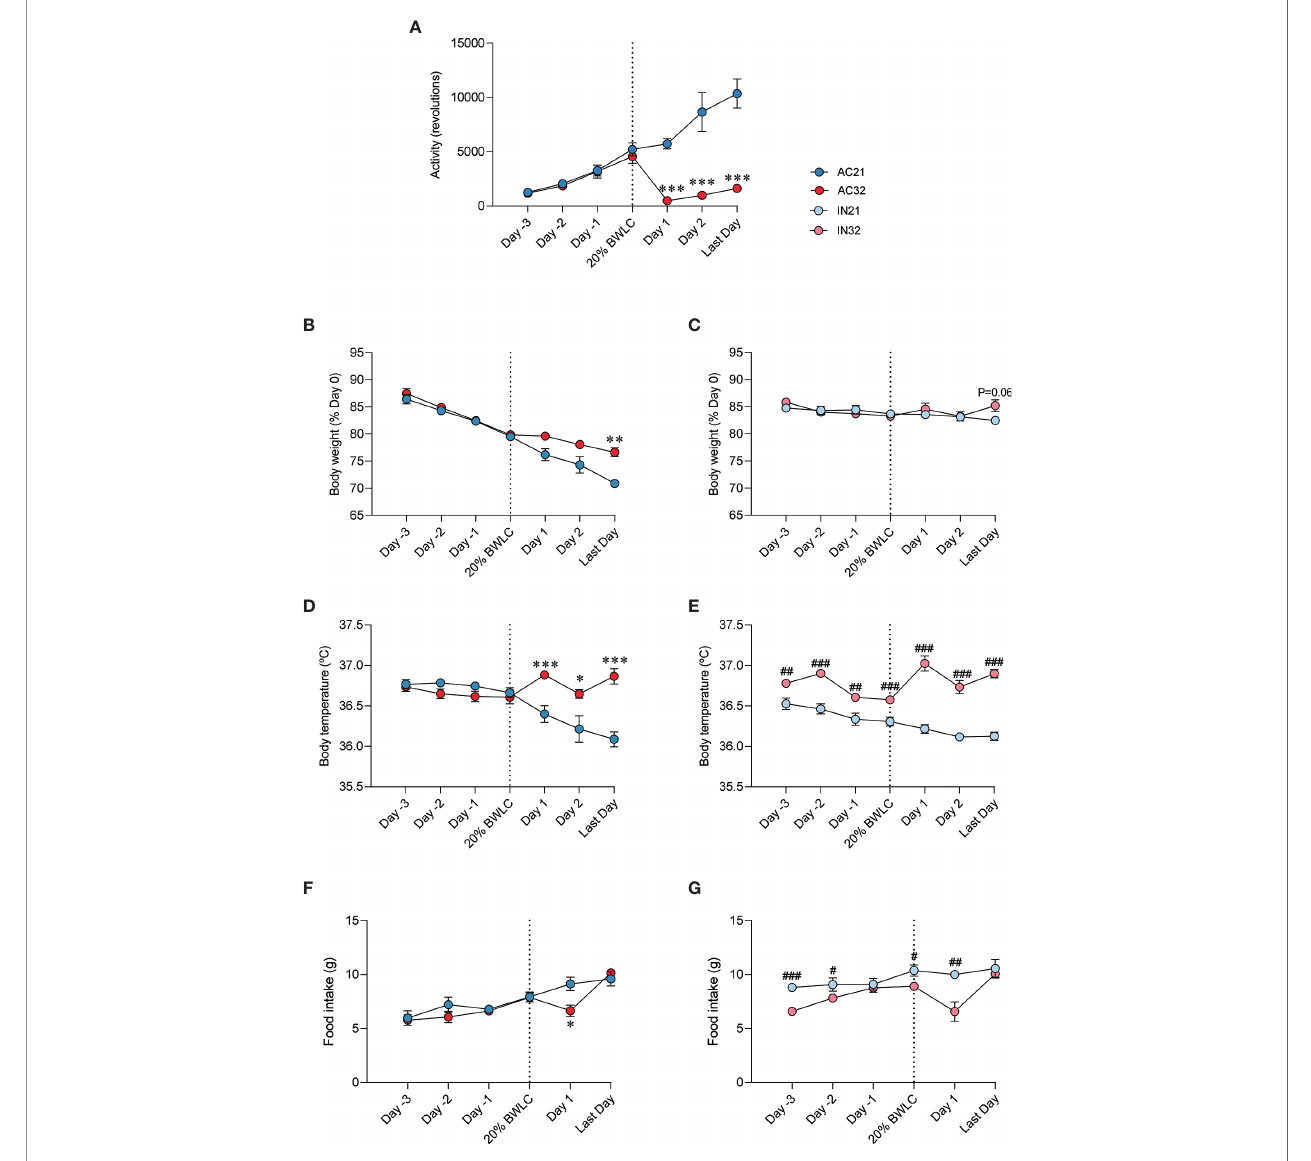
FIGURE 1 | Effect of ABA and temperature on energy balance. (A) Activity (n = 9-12 rats/group) (B, C) Body weight (% of day 0) (n = 8-12 rats/group) (D, E) Body temperature (n = 7-10 rats/group) (F, G) Food intake (n = 8-12 rats/group) of active rats at 21°C and 32°C (AC21 and AC32) and inactive rats at 21°C and 32°C (IN21 and IN32) *P < 0.05, **P < 0.01, ***P < 0.001 vs. AC21; # P < 0.05, ## P < 0.01, ### P < 0.001 vs. IN21. Data expressed as mean ± SEM. 20% BWLC, 20% body weight loss